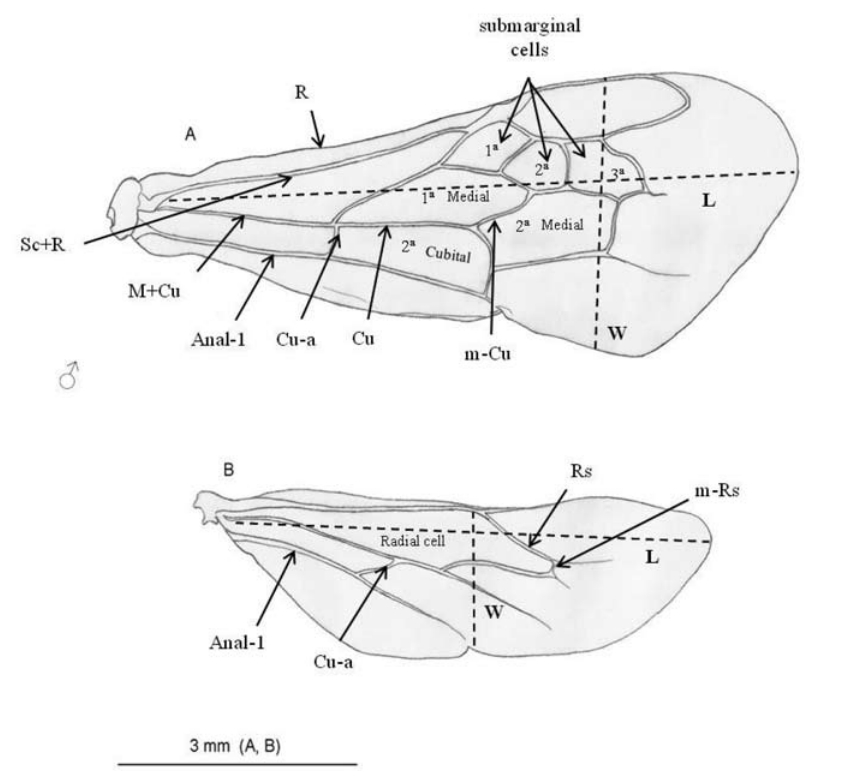
Fig. 3 – Linear measurements of morphological characters of the forewing (A) and hindwing (B) male Tetrapedia diversipes by conventional morphometric. Legend: Length (L), width (W), Radial + Subcostal veins (Sc + R), Cubital vein (Cu), Cubital-anal (Cu-a), Middle-Cubital or median- Cubital (m-Cu), Radial (R), Radial sector (Rs), median-Radial sector